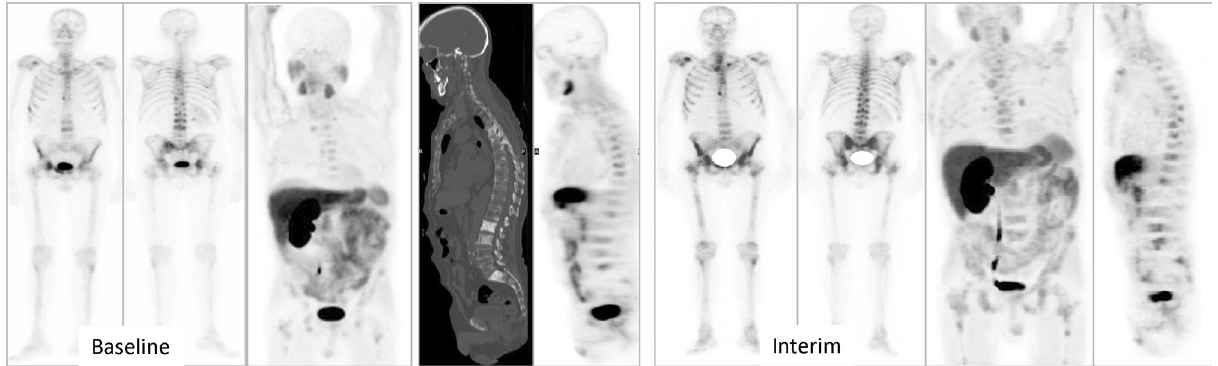
Figure 6. Patient ≠ 4. Baseline BS and FCH PET/CT shows polimetastatic disease with progression on interim images. 66 years old man, Gleason 9, 223 Ra in second line, baseline PSA: 57 ng/ml. PFS and OS of 3 and 14 months,